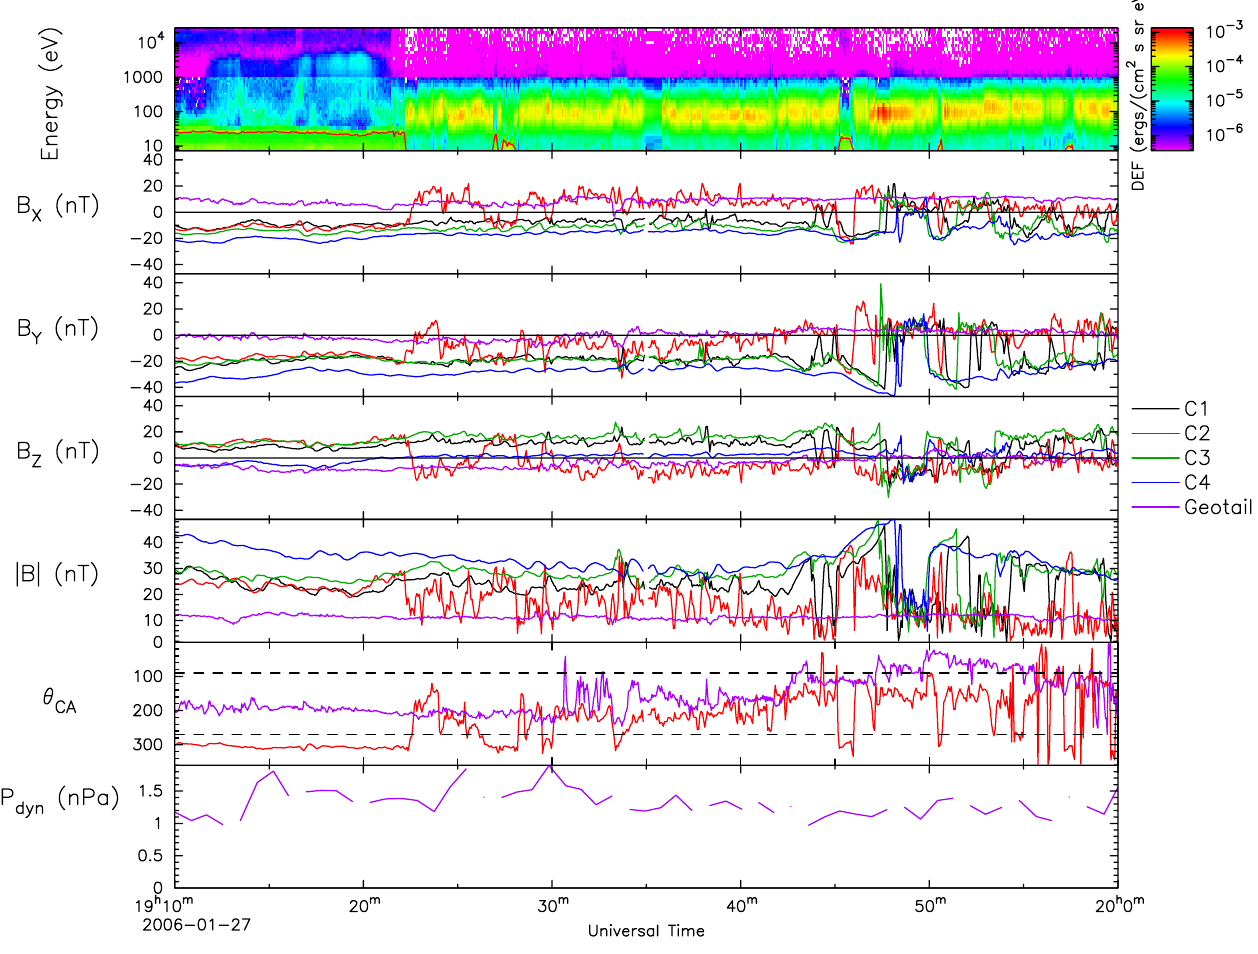
Fig. 3. An overview of the Cluster observations. From top: an omnidirectional PEACE spectrogram from Cluster 2; the magnetic fields measured by the Cluster FGM and Geotail MGF instruments in GSM coordinates; the clock angle ( θ CA = arctan [ B Y /B Z ] ) of the IMF observed by Geotail (purple line) and the magnetospheric/magnetosheath magnetic field observed by Cluster 2 (red line), and the solar wind dynamic pressure observed by the Geotail CPI instrument. The IMF has been multiplied by a factor of four to enable comparison with the magnetosheath magnetic